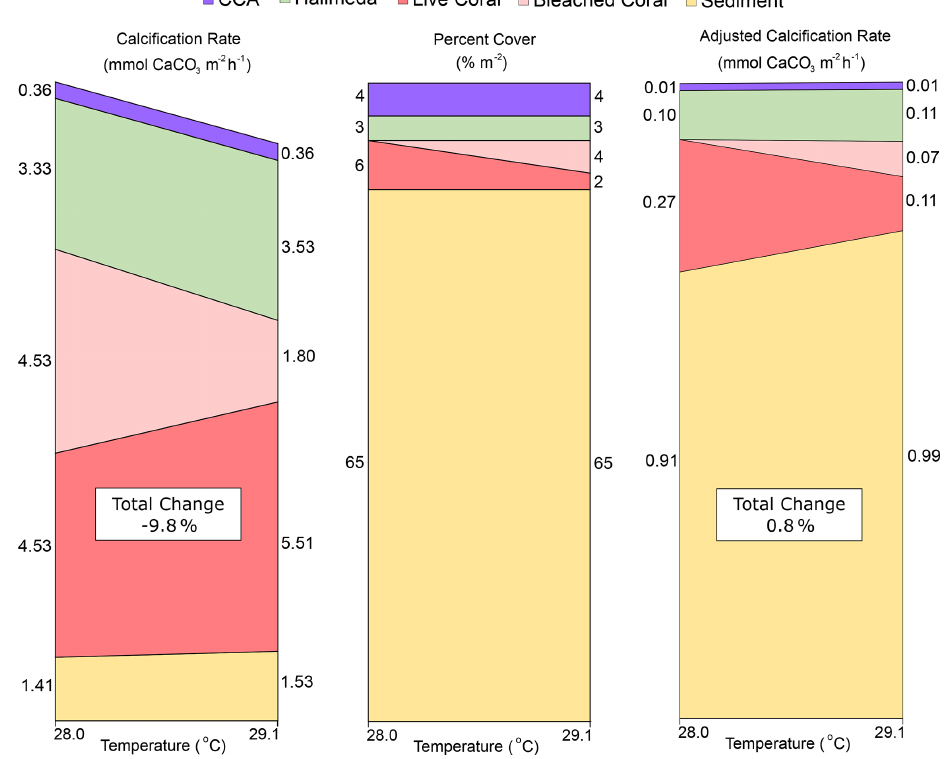
Figure 4. Visualization of the changes caused by a transition from pre-bleaching (28.0 ◦ C) to bleaching (29.1 ◦ C) temperatures in (a) esti- mated individual organism calcification rates from the literature (converted to mmol CaCO 3 m − 2 h − 1 ), (b) percent cover across lagoon site 1 and lagoon site 2 combined, and (c) the “adjusted calcification rate” (mmol CaCO 3 m − 2 h − 1 ) calculated by multiplying (a) by (b) at each temperature. Total change (%) represents the percent difference in the sum of all rates at 29.1 ◦ C relative to 28 ◦ C. Rubble and other calcifier categories were assumed to be CCA and Halimeda spp.,